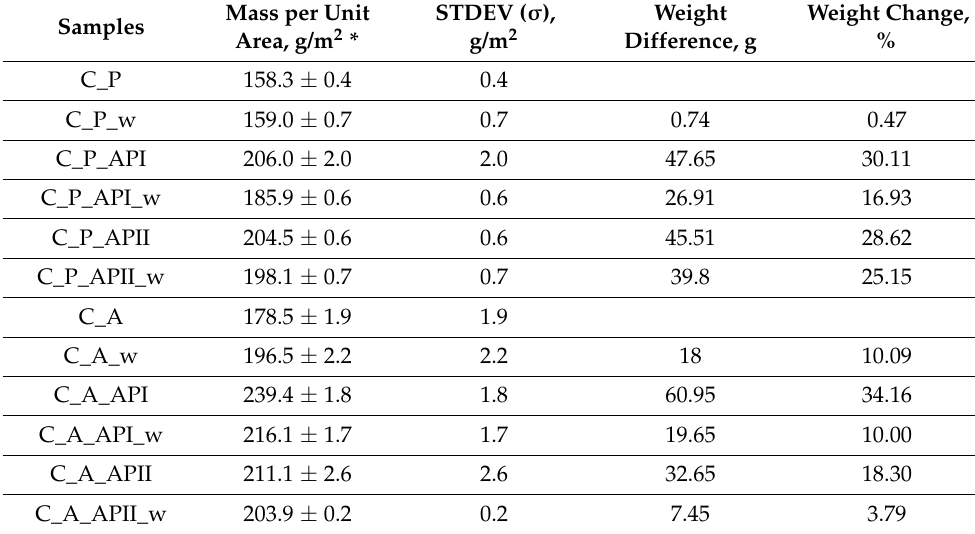
Table 5. The change in the mass per unit area of the